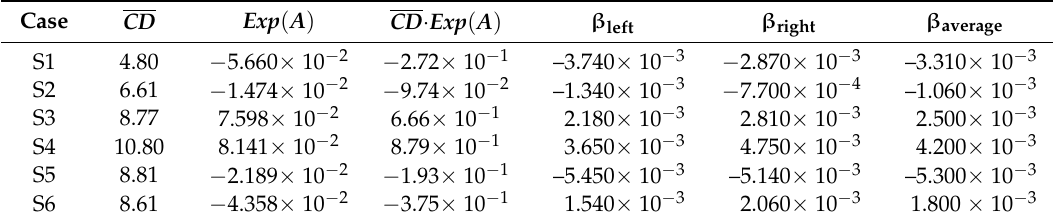
Table 2. Calculated CD and Exp ( A ) , as well as the measured angular distortions of cases S1–S6.